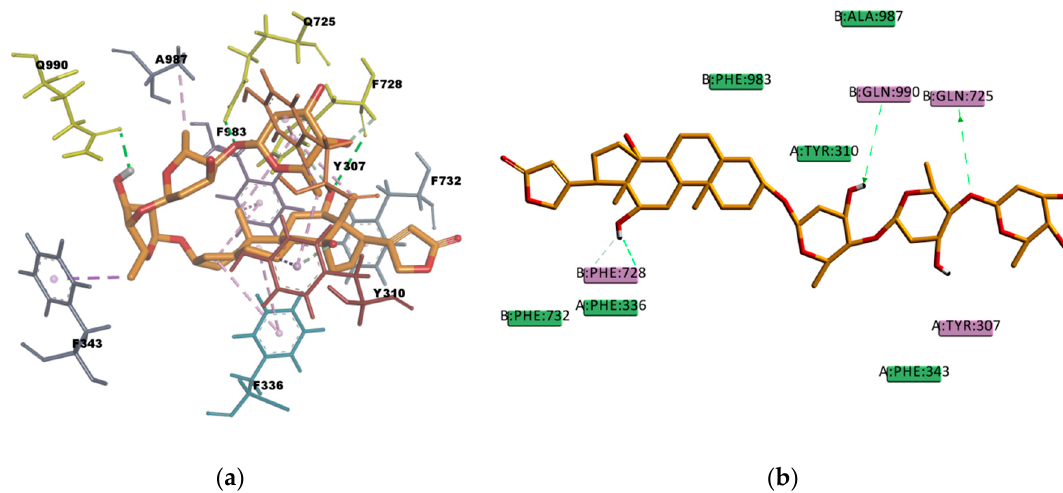
Figure 13. Digoxine (DIG) top-ranked pose obtained with CDOCKER algorithm. ( a ) 3D view of DIG interactions in the binding pocket. Green dotted lines represent conventional hydrogen bond interactions and light-rose dotted lines represent hydrophobic interactions. Residues Q725, Q990, and F728 involved in hydrogen bond interactions are colored yellow; ( b ) 2D interaction diagram of DIG with h P-gp interacting residues. The green dotted lines represent conventional hydrogen bond interactions. The light-green dotted line represents a π –donor hydrogen bond interaction.